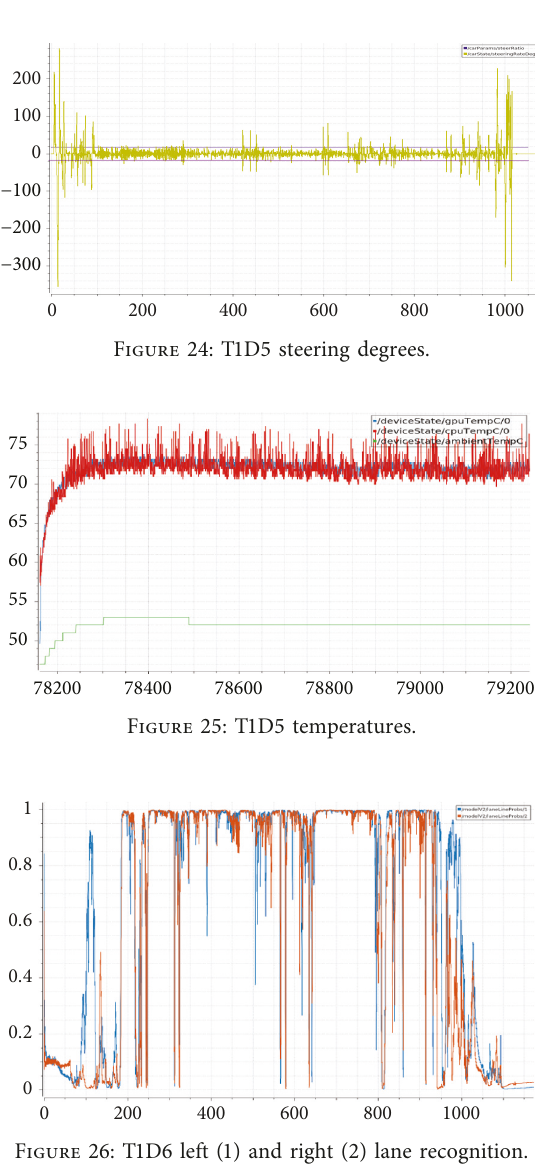
Figure 23: T1D5 driver awareness.